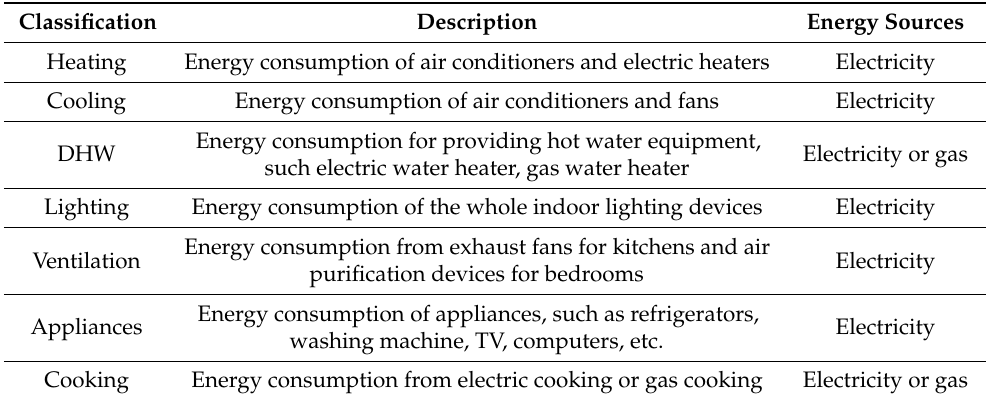
Table 3. Classification of end-use energy consumption in residential